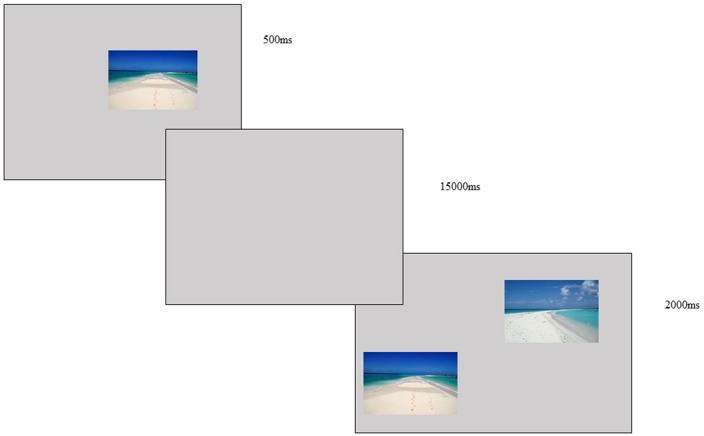
DMTS task—image presented for 500 ms, with a delay of 15,000 ms and two images presented for 2,000 ms, the subject was asked to choose the image first presented and use a mouse to click on the correct choice.